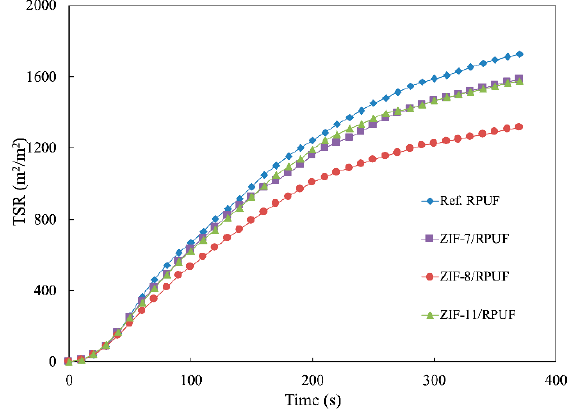
Figure 11. Total smoke release (TSR) curves of Ref. RPUF, ZIF-7/RPUF, ZIF-8/RPUF and ZIF-11/RPUF.